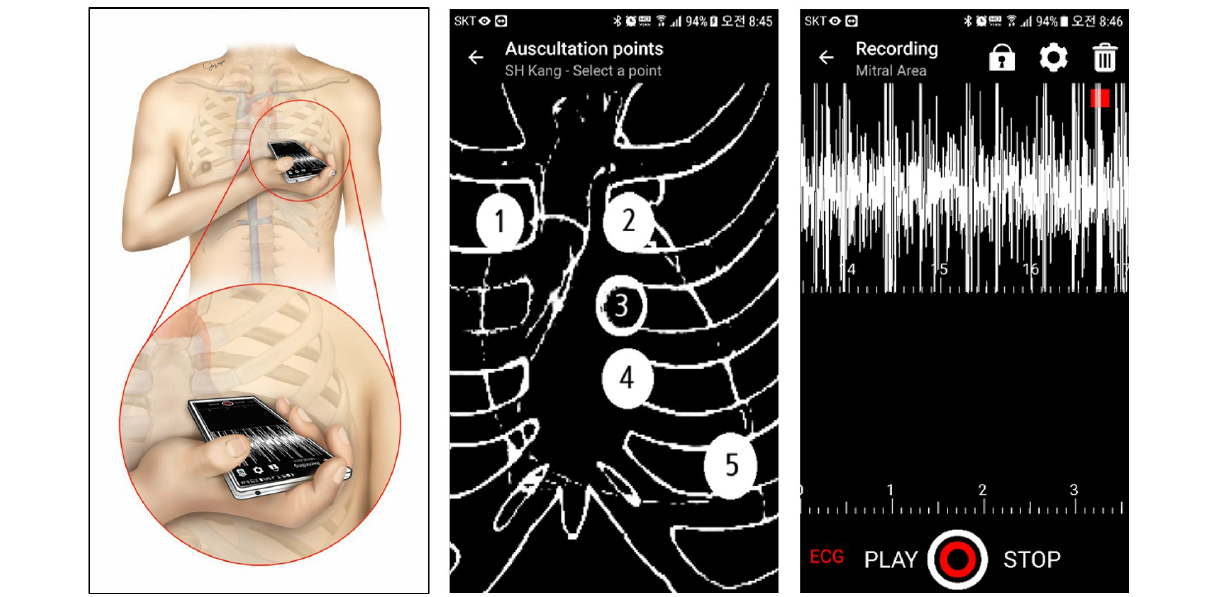
Figure 1. Heart sound recording using a smartphone app. Left: illustration of how the heart sounds were recorded in this study. Smartphones were placed directly on the chest wall; a dedicated app was used with no add-on devices. Middle and right: representative screenshots of the app (called CPstethoscope) developed for this study. ECG: